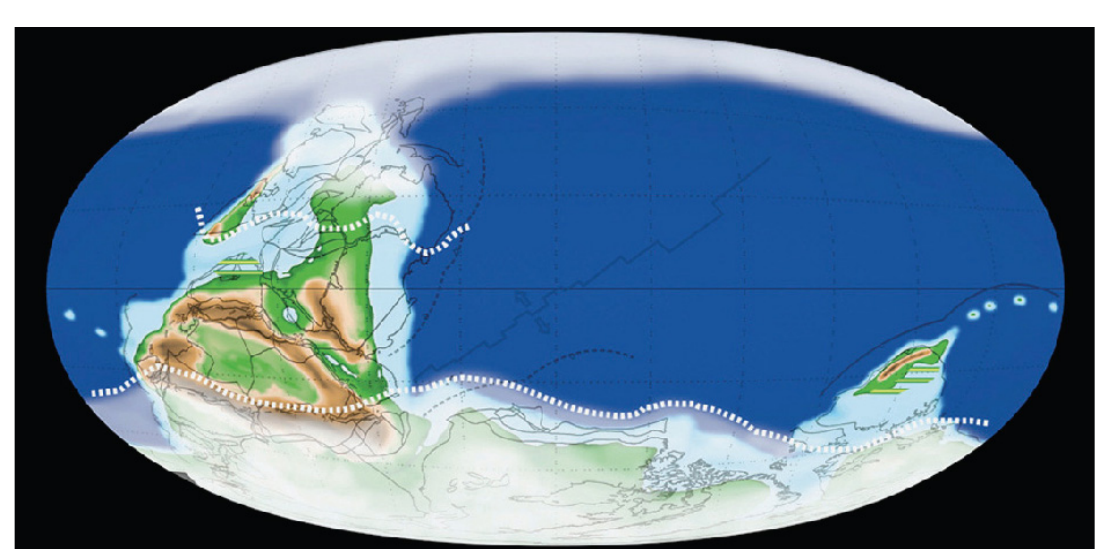
Figure 1. The image of an ice-encased Earth- a Snowball Earth, with oases of open water on which life could survive in refugia during a Neoproterozoic ice-house event? From Scotese (2009) [8], re-published with permission of the Geological Society of